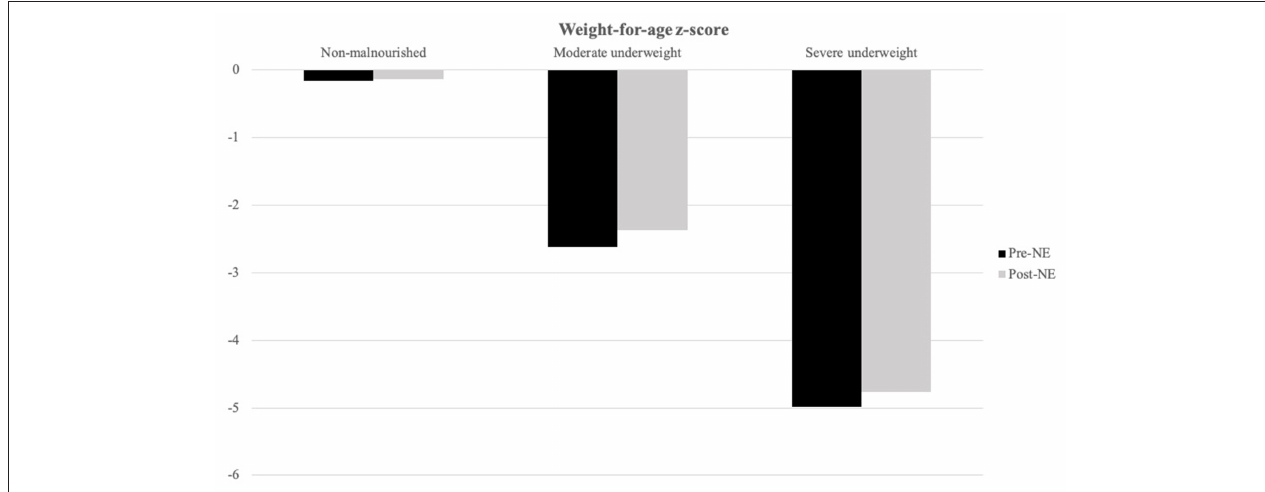
FIGURE 2 | Weight-for-age z -score alternations after NE tube placement is stratified by baseline weight-for-age z -score. Moderate underweight (baseline weight-for-age z -score between − 3 and − 2, N = 8) and severe underweight group (baseline weight-for-age z -score below − 3, N = 35) showed better weight-for-age z -score increment after NE tube placement than non-malnourished (baseline weight-for-age z-score above − 2, N = 30) group patients.